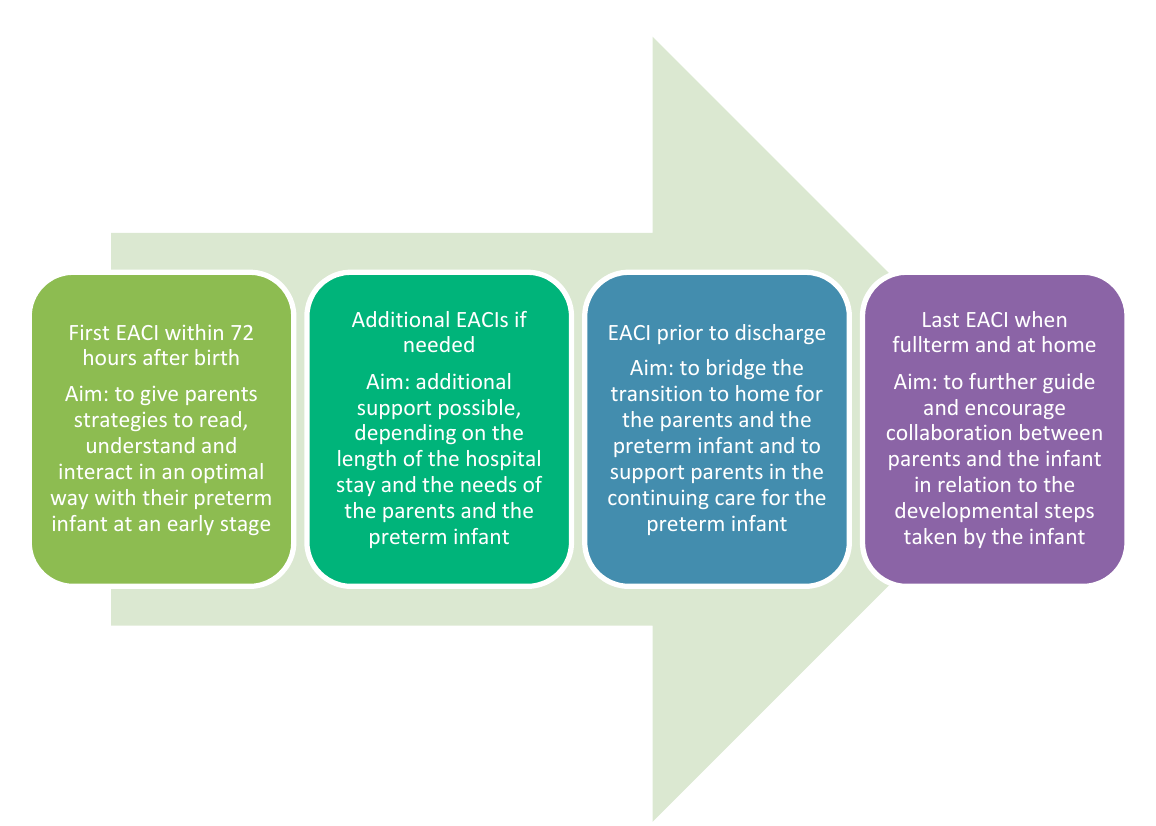
Figure 1. Flowchart of the EACIs and a description of the content during each session.